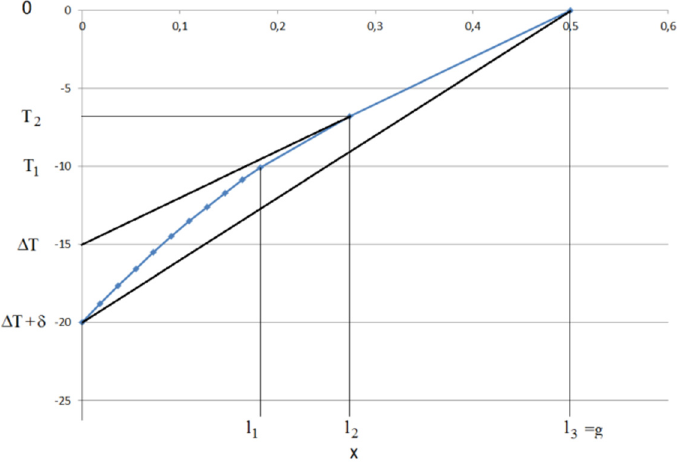
Figure 13. Calculated temperature distribution.